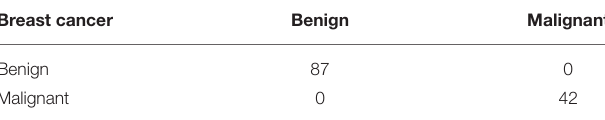
TABLE 12 | Confusion matrix of dataset A2